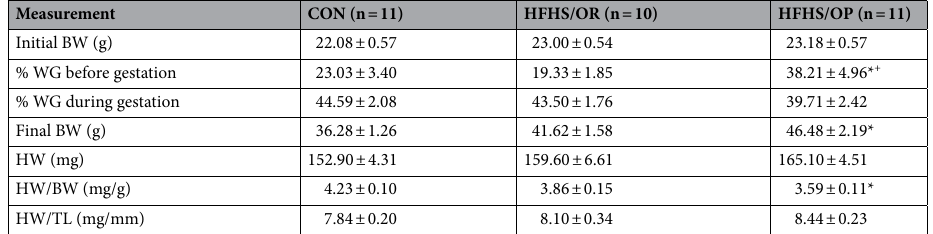
Table 1. General characteristics of dams. Values are expressed as mean ± SEM. CON, control; HFHS/OR, obese-resistant mice fed a high-fat, high-sucrose diet; HFHS/OP, obese-prone mice fed a high-fat, high- sucrose; BW, body weight; HW, heart weight; TL, tibial length; WG, weight gain. * P < 0.05 versus CON, + P < 0.05 versus